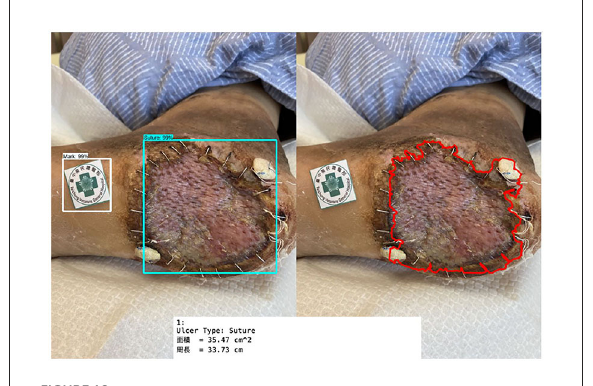
FIGURE12 Wound contour identification for suture type of ulcers in a DFU foot.